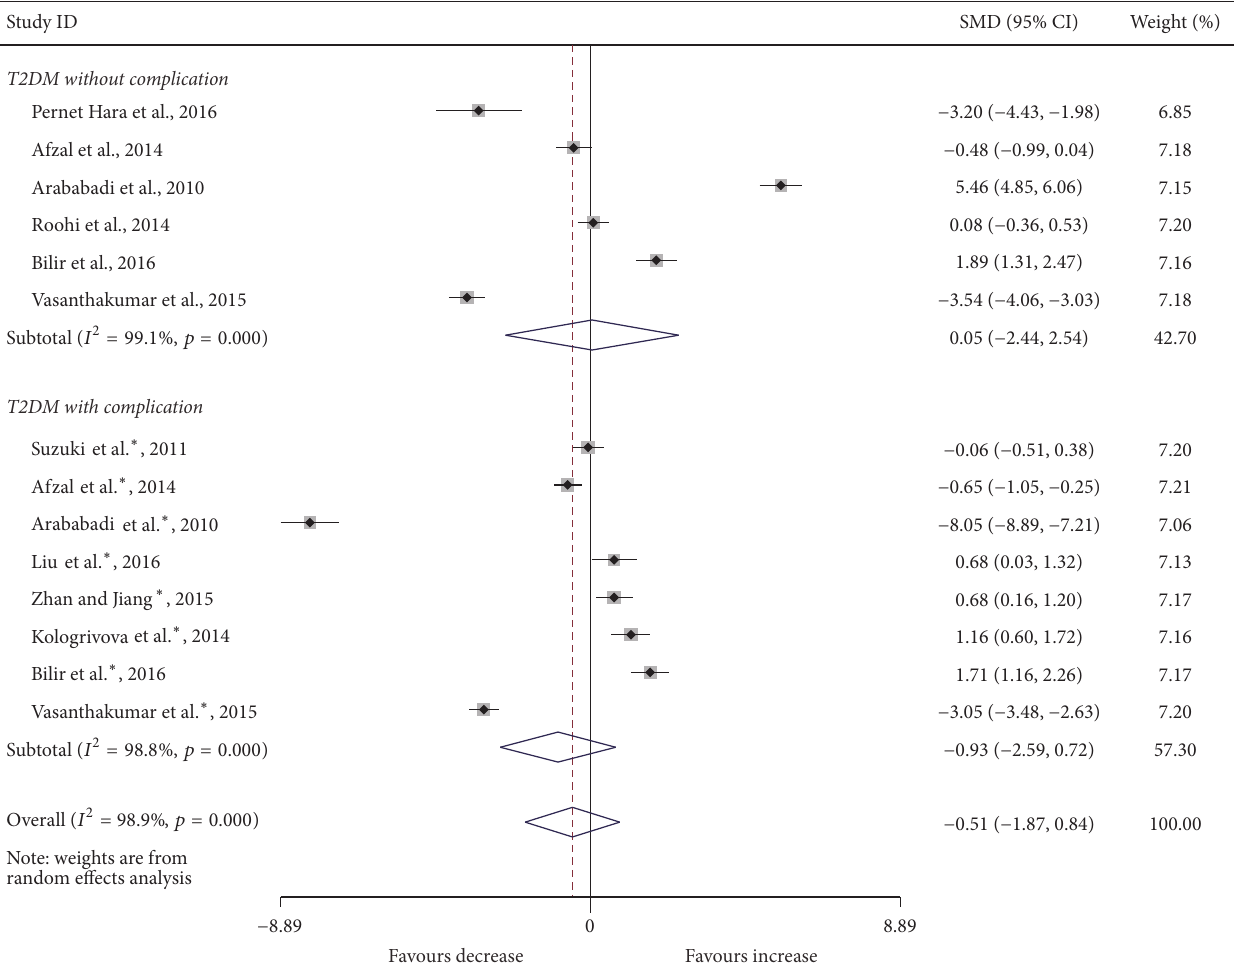
ry IL-10, TGF- 𝛽 , and TNF- 𝛼 . The presence of diabetic com- plication has an impact on the compromised immunosup- pression. Significant interaction exists between immune and metabolic